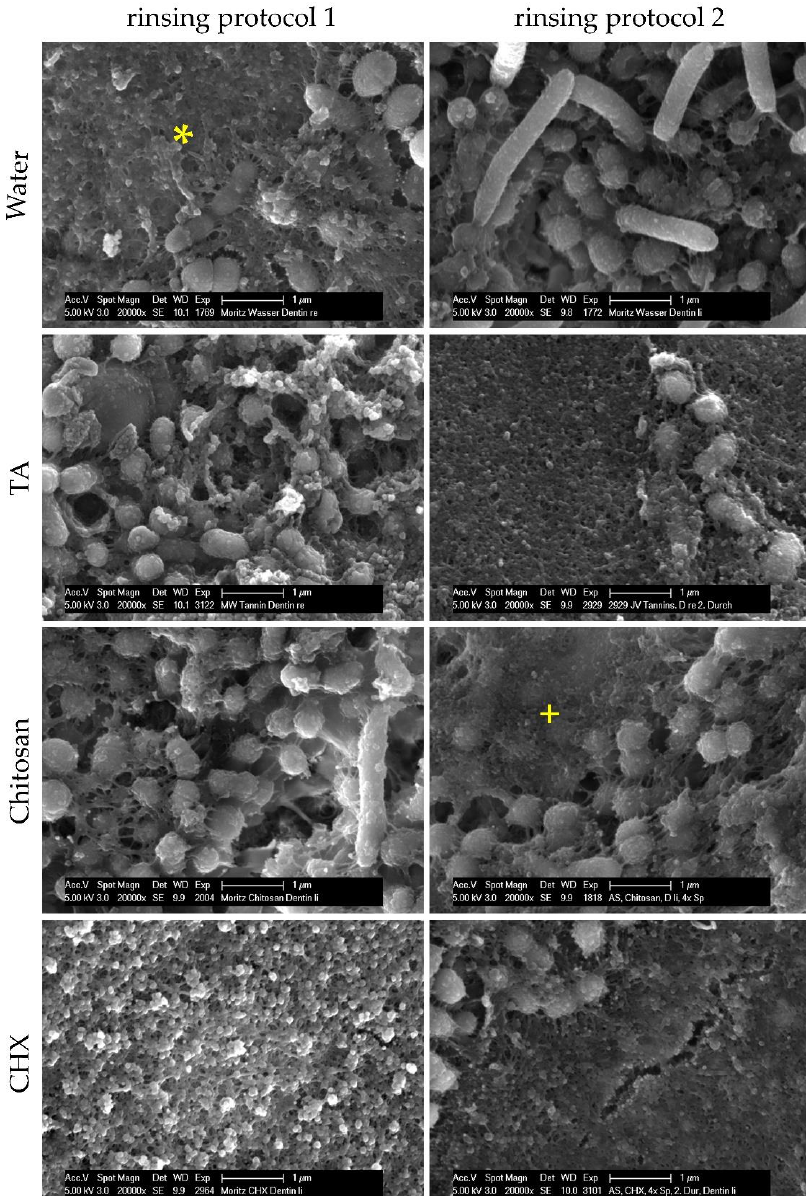
Figure 3. SEM images of dentin specimens at 20,000-fold magnification. Subjects carried intraoral splints with dentin specimens for 48 h and rinsed with different experimental solutions. In rinsing protocol 1, rinsing was performed after 3 min, 12 h, 24 h, 36 h and 47.5 h and in rinsing protocol